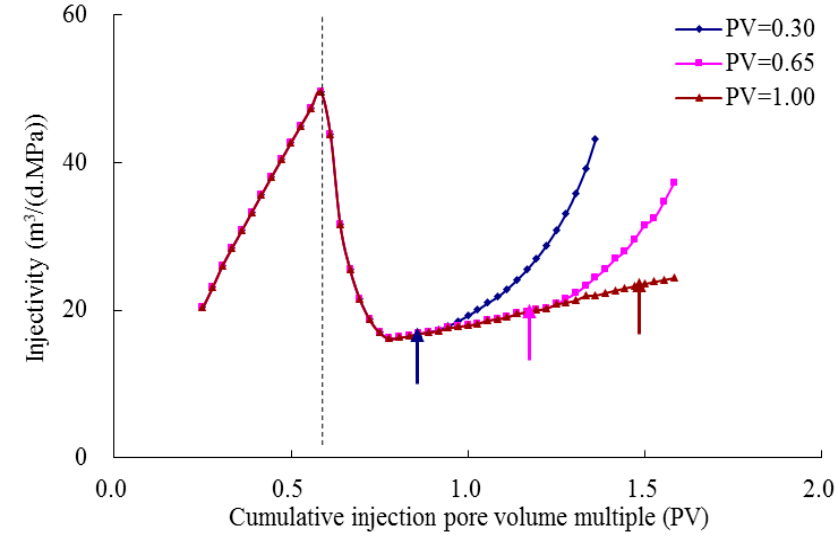
Figure 12. The influence of polymer injection volume on injectivity.